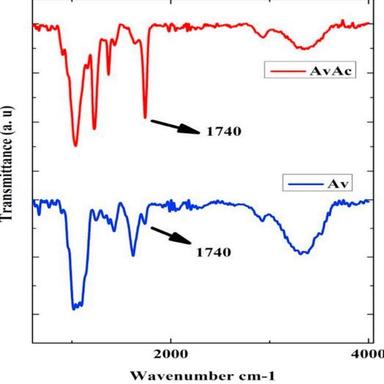
FT-IR spectra of Av, AvAc powder.